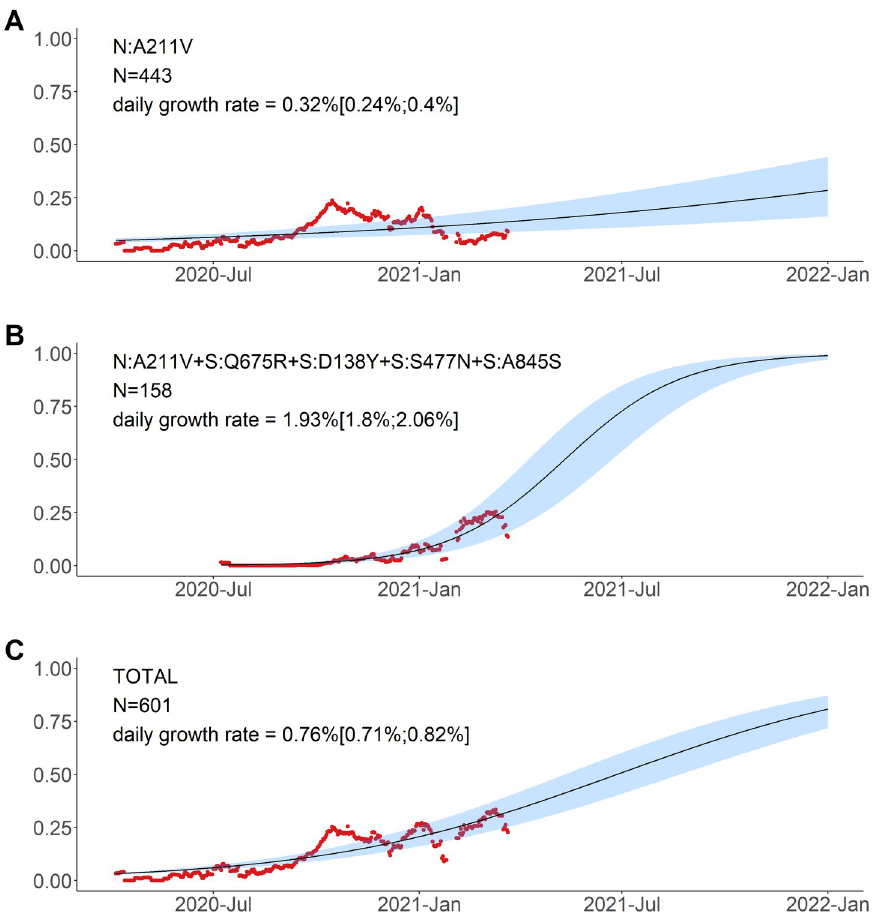
Fig 6. Logistic growth model for nested variants defined by amino acid changes in the N:A211V context. Red dots, sliding window 14-day average frequency; shaded area, 95% confidence interval. Variants are identified according to the presence of the mutations in S and N proteins; see Fig 5 for complete lists of mutations in the corresponding